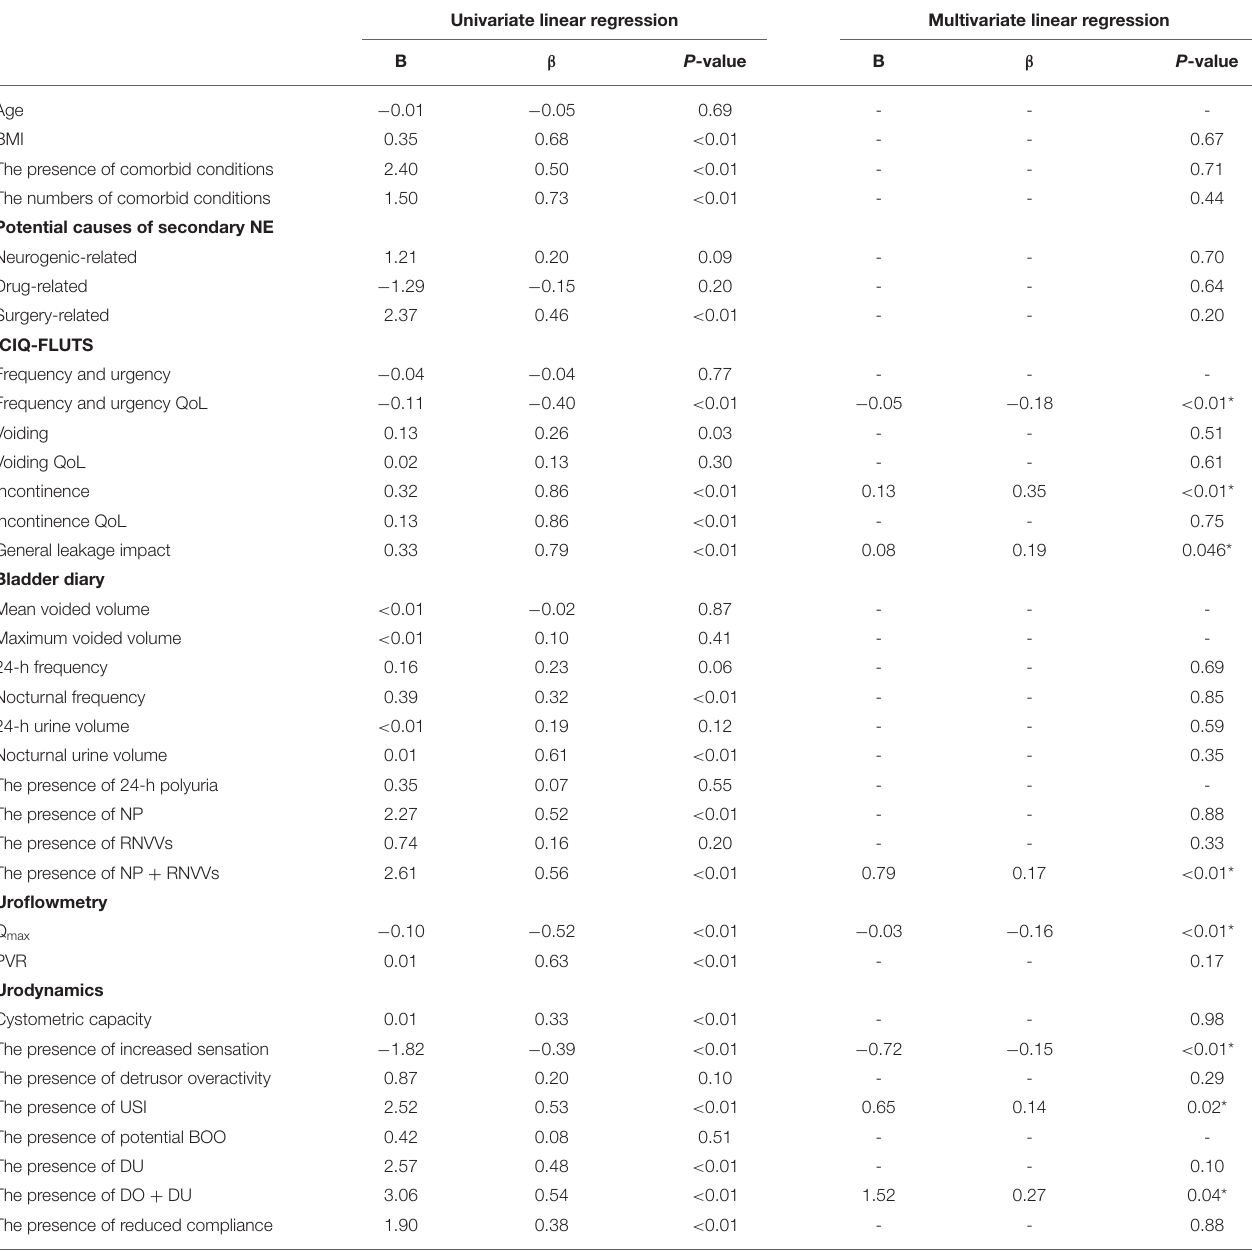
TABLE 4 | Potential risk factors associated with nocturnal enuresis severity. Univariate linear regression Multivariate linear